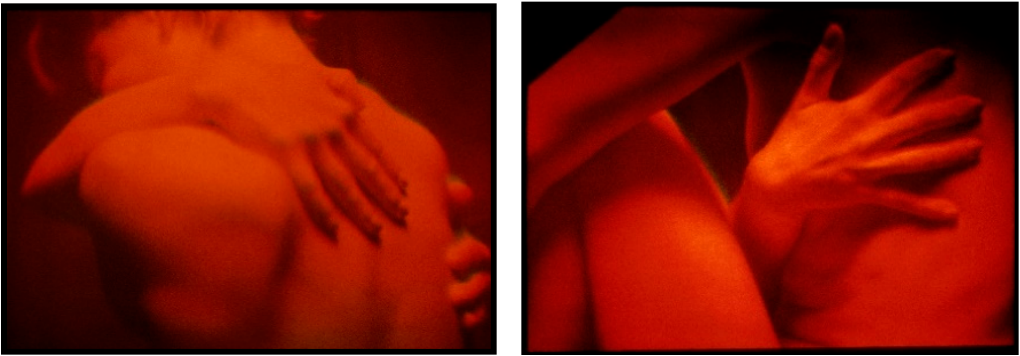
Figure 7. Pseudo colour reflection holograms, 30 cm × 40 cm, from the series Is This What You Want? Figure 8 is an image of a suspended hologram in front of a 5